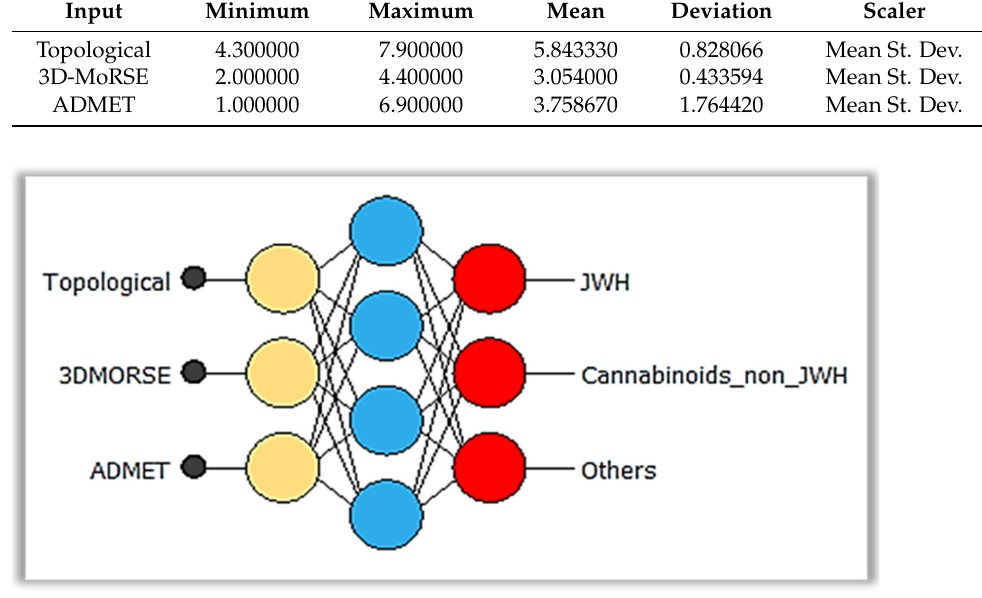
Figure 2. Network architecture, version 1: scaling layer (yellow), perceptron layer (blue), probabilistic layer (red).